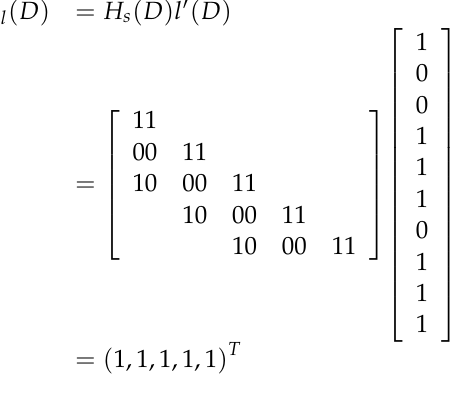
Figure 4. 3-Ary, constraint length = 4, η = 4.37. Figure 4. 3-ary, constraint length = 4, Figure 4. 3-ary, constraint length = 4,